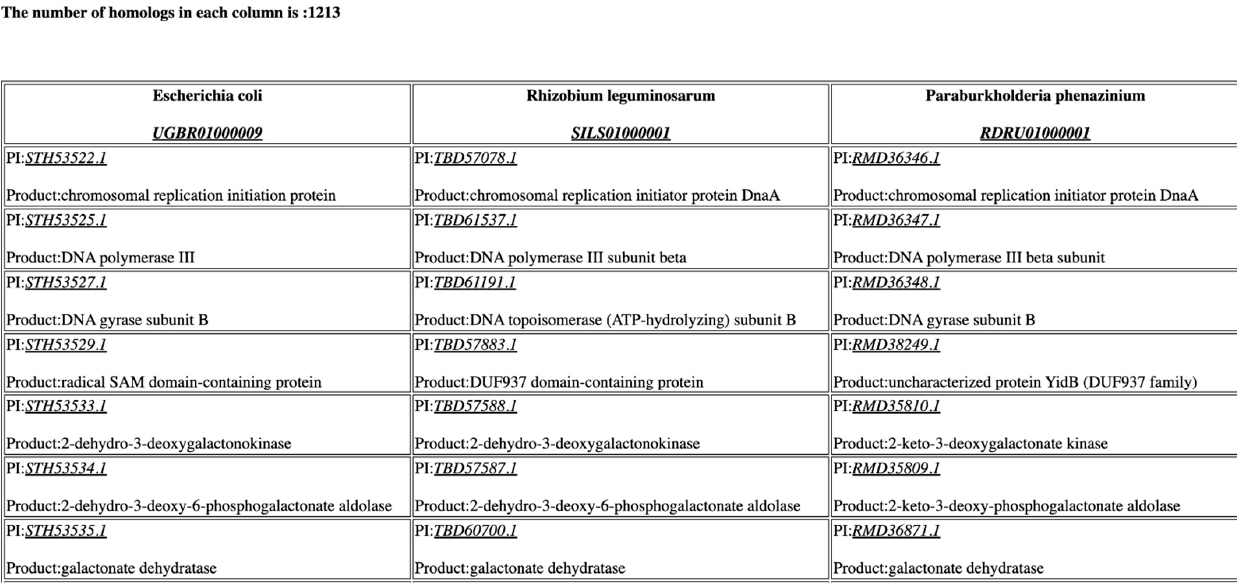
Figure 3. Partial CoreGenes output from three bacterial genomes approximately 5 Mb in size. The links to the complete genomes and individual proteins are shown. As noted, the number of core genes identified is 1213.